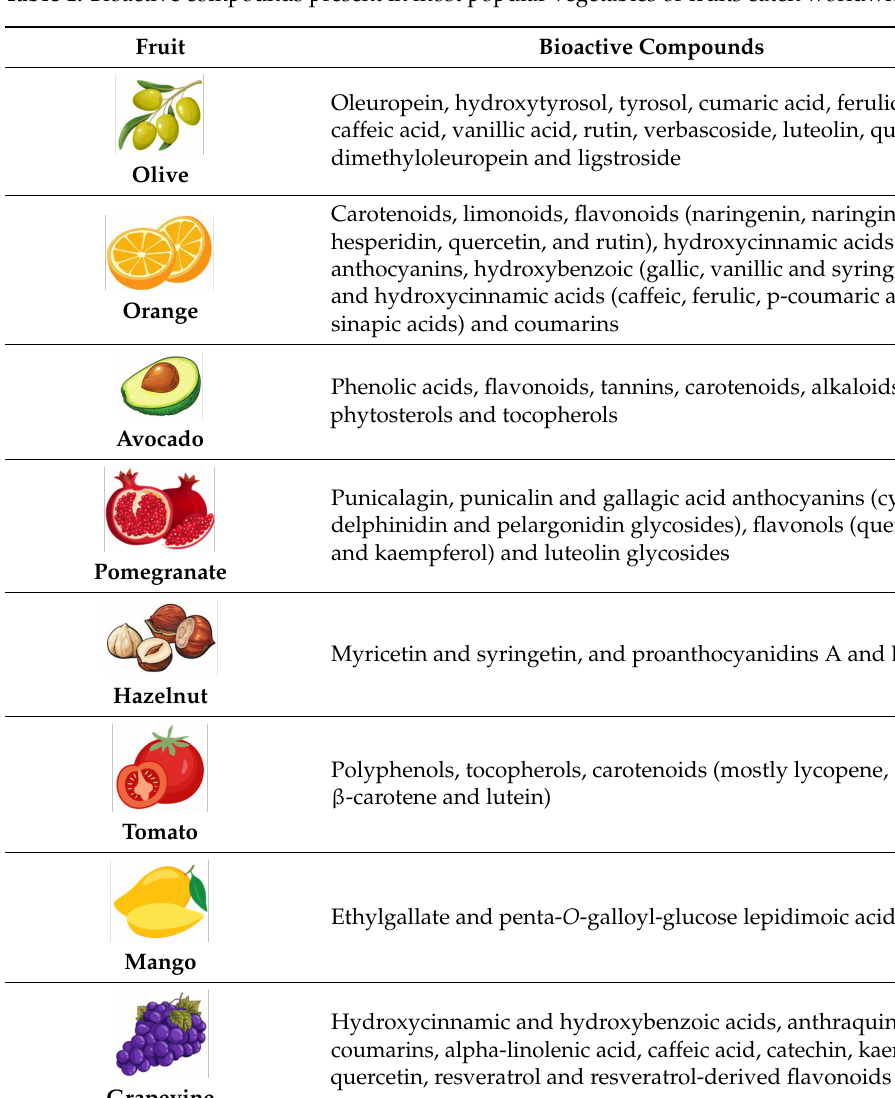
Table 1. Bioactive compounds present in most popular vegetables or fruits eaten